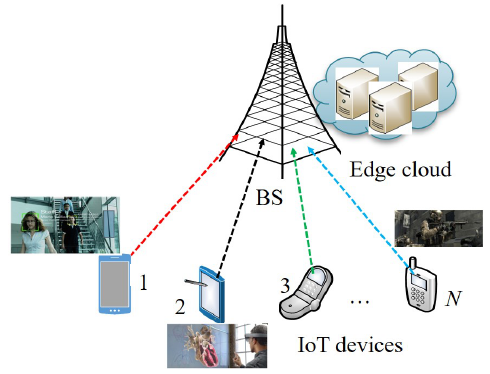
Figure 2. MEC-assisted social IoT